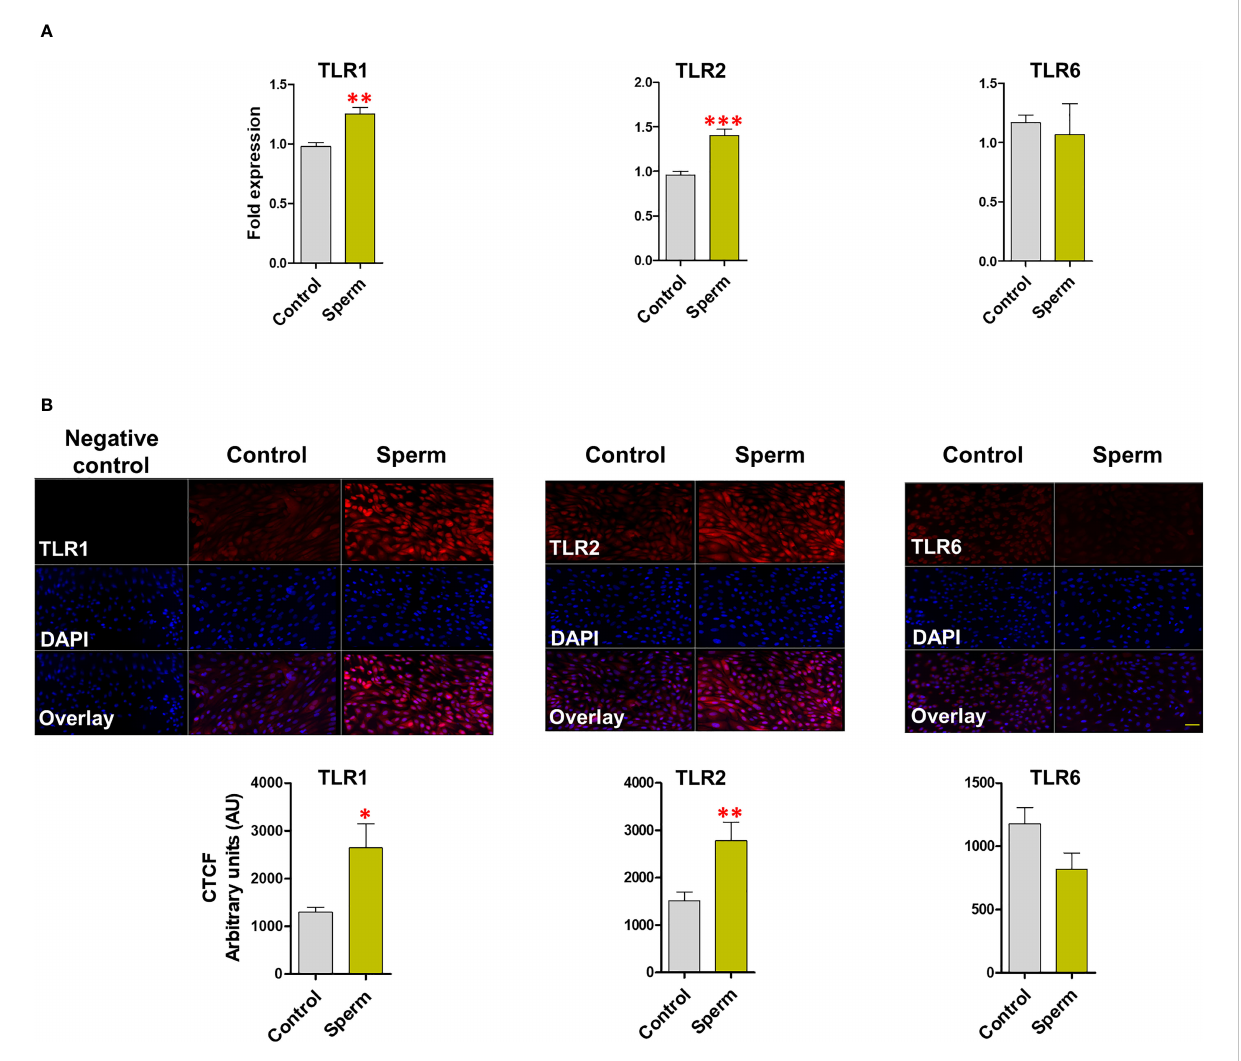
FIGURE 2 Sperm induce TLR2 and TLR1 (not TLR6) expression in BEECs. (A) Relative mRNA expression of TLR1, 2 and 6 in BEECs after 3h co-culture with 5 million/mL sperm. (B) Immuno fl uorescence staining of TLR1, 2 and 6 in BEECs monolayer. This experiment was repeated seven times using epithelial cells from seven different uteri. Asterisks show a signi fi cance of difference (*P < 0.05, **P < 0.01, or ***P < 0.001) in the treatment group when compared to the control group. Bar = 50